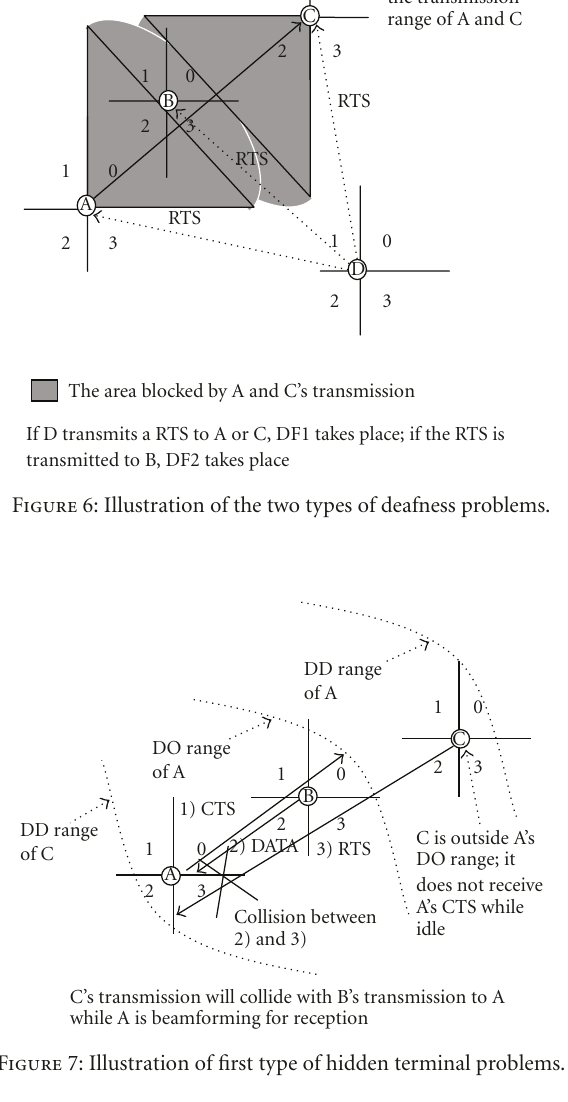
Figure 7: Illustration of first type of hidden terminal problems.